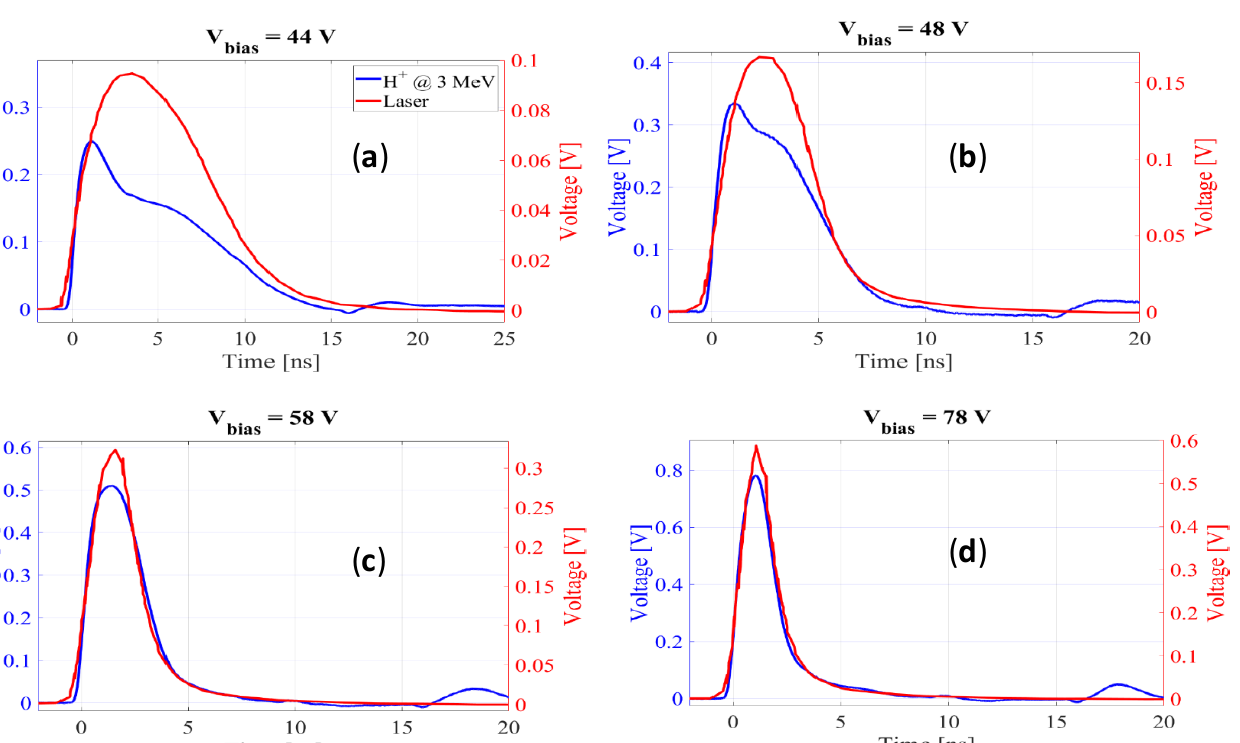
Figure 12. ( a ) SRIM simulations of the energy deposited by a 3 MeV proton beam entering from the top with an in c ident angle of 0°, 30° and 50°. The red dashed line indicates the end of the active layer. ( b ) Profile of the ionization density projected on the x axis for angles up to 50°. ( c ) Absolute gain versus the mean linear ionisation density at 130 V.